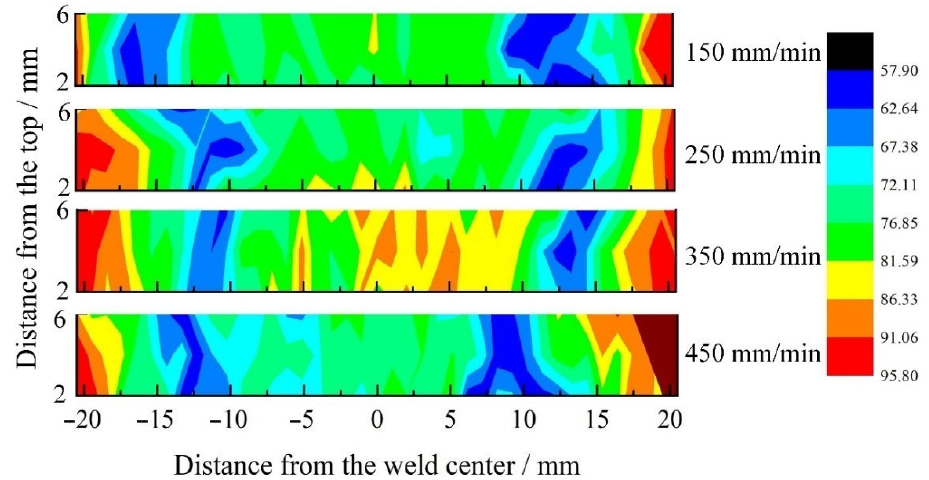
Figure 9. 2D hardness maps through the joints at a rotation speed of 400 rpm and different welding